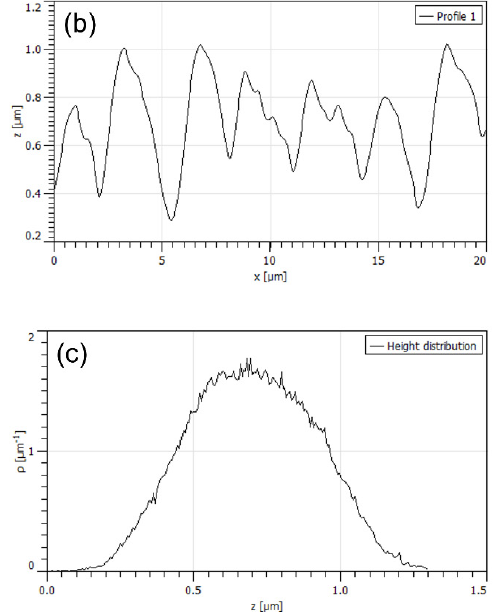
Figure 6. ( a ) Three-dimensional AFM image, ( b ) profile and ( c ) height distribution of the thiol-ene surface hot embossed at 100 °C under 30 MPa for 1 h. The red line indicates the location where the AFM profile was extracted.